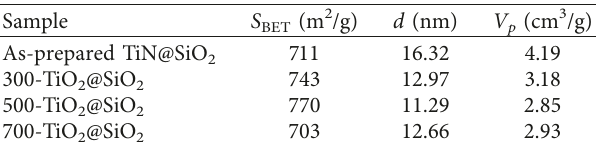
Figure 1: Adsorption-desorption isotherm and pore size distri- bution of TiN@SiO 2 composite aerogel. Table 1: Specific surface area ( S BET ), average diameter ( d ), and mesopore volume ( V p ) of the aerogel